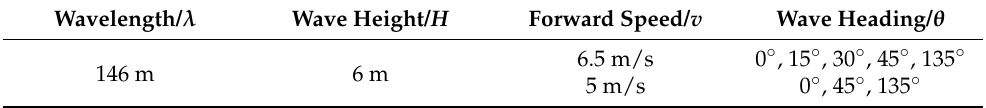
Table 3. CFD simulation conditions.